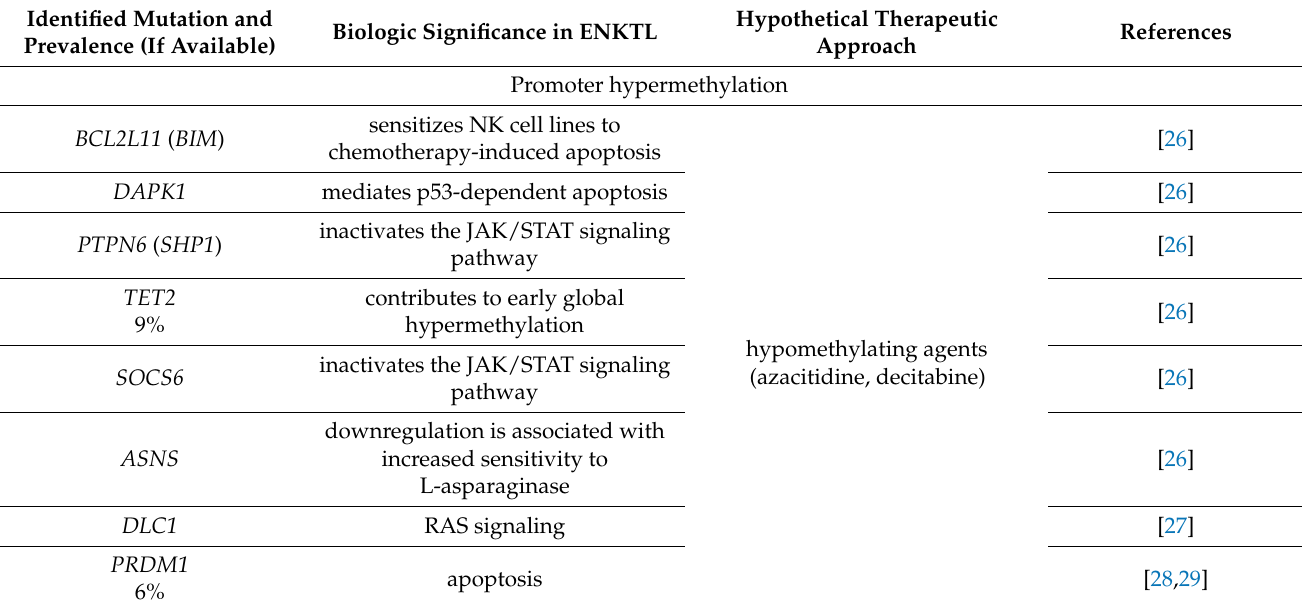
Table 1. Putative driver mutations in ENKTL and potential therapeutic approaches. Identified Mutation